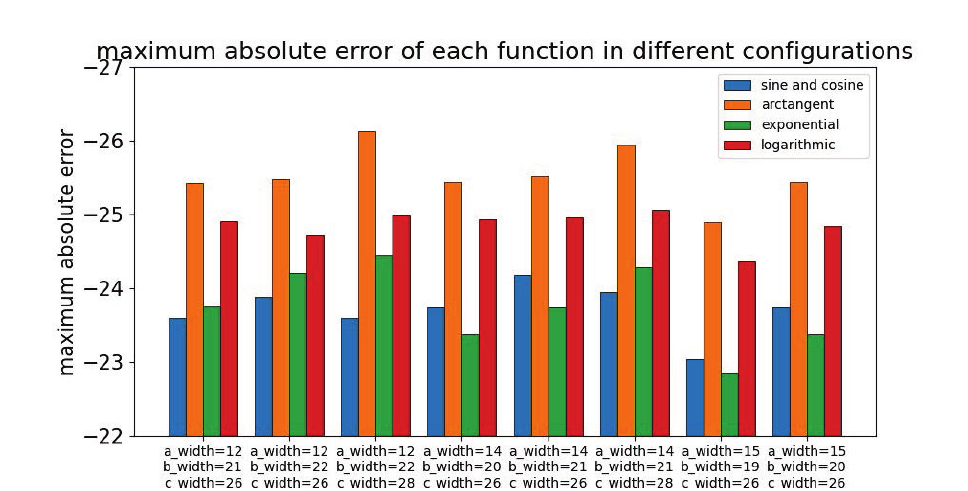
Figure 4. The relationship between the maximum error and the different configurations.